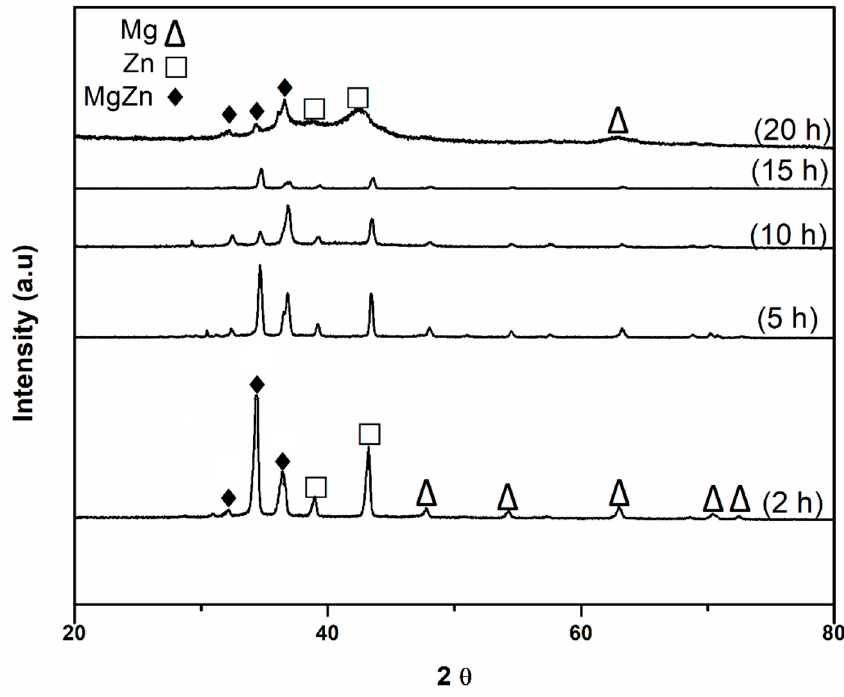
Figure 7. XRD patterns of Mg70–Zn25–Ca5 mechanically alloyed for milling times of 2, 5, 10, 15, and 20 h.